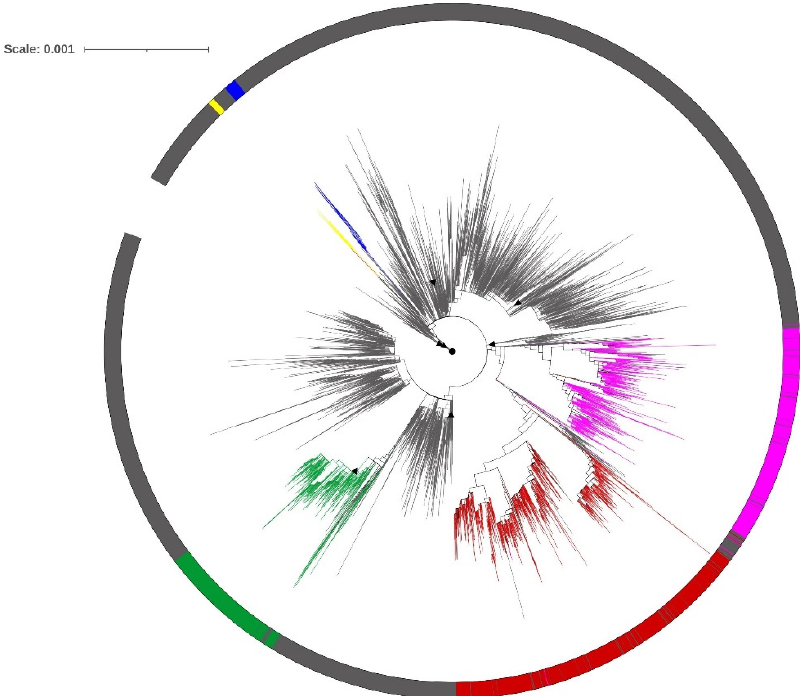
Figure 3. Phylogenetic tree derived using the Maximum Likelihood method for complete genome sequences (6859) of various SARS-CoV-2 lineages labeled as variants of concern and variants of interest. Lineages that are not designated as VoC/VoI are labeled as Others. Color codes: Alpha (green), Beta (blue), Delta (red), Kappa (magenta), Eta (yellow), and Others (gray). The Wuhan isolate (NC_045512.2) is denoted as a circle (black), and reference genomes are denoted with triangles (black).